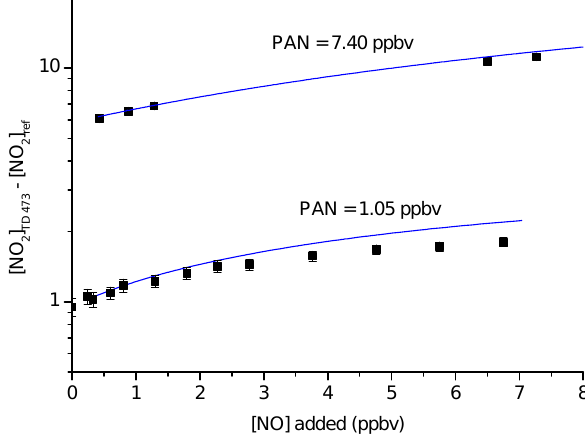
Figure 7. Measurements of the difference signal (TD cavity sam- pling from the 473K inlet – NO 2 reference cavity) with various amounts of NO 2 added and at three different PAN concentrations (0.79, 2.45 and 7.50ppbv). The error bars represent standard devi- ation and were derived by propagating errors in the NO 2 signals in the TD and reference cavities. The blue lines show the results of numerical simulations as described in Sect. 2.1.7.